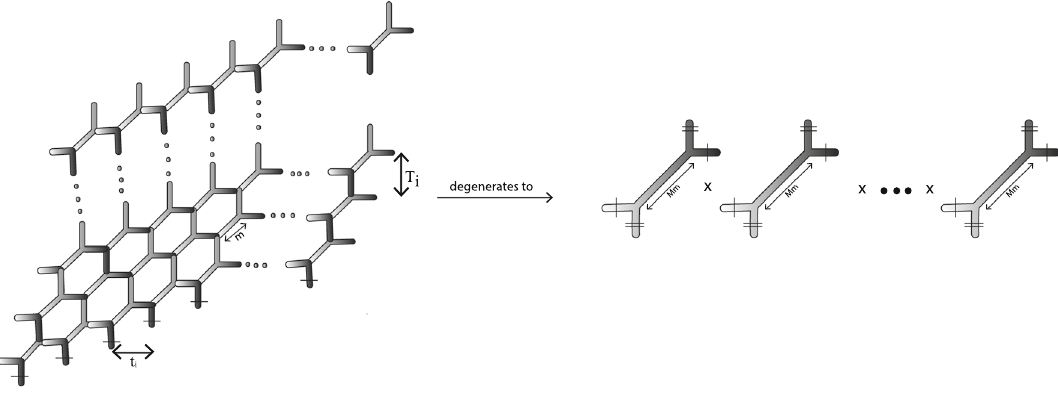
Fig. 6 Z N , M degenerating to ( Z 1 , 1 )